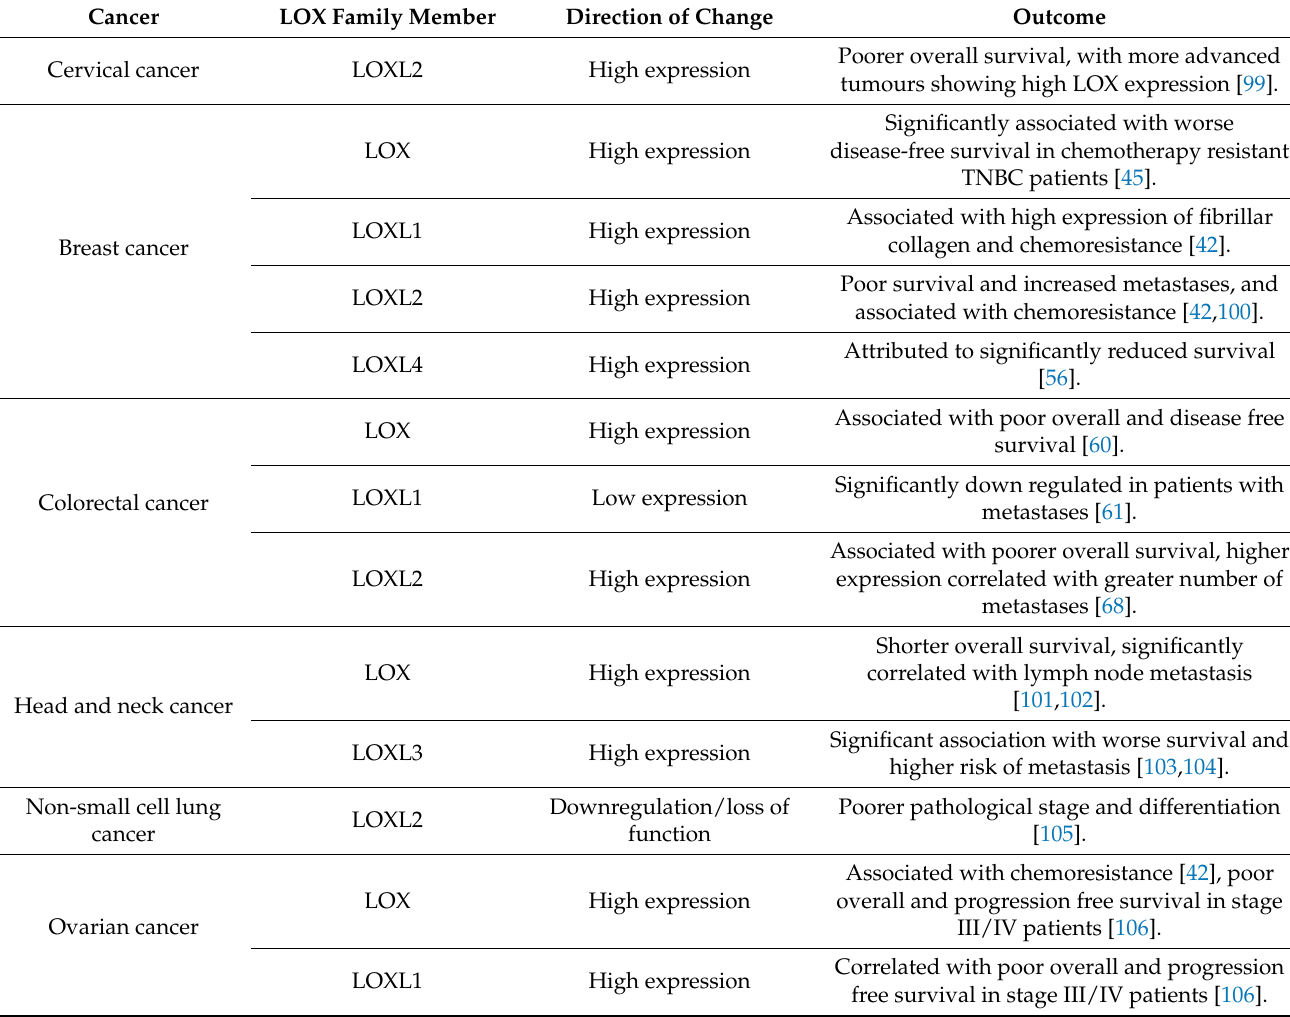
Table 3. LOX family members identified as a prognostic marker/biomarker of disease. Cancer LOX Family Member Direction of